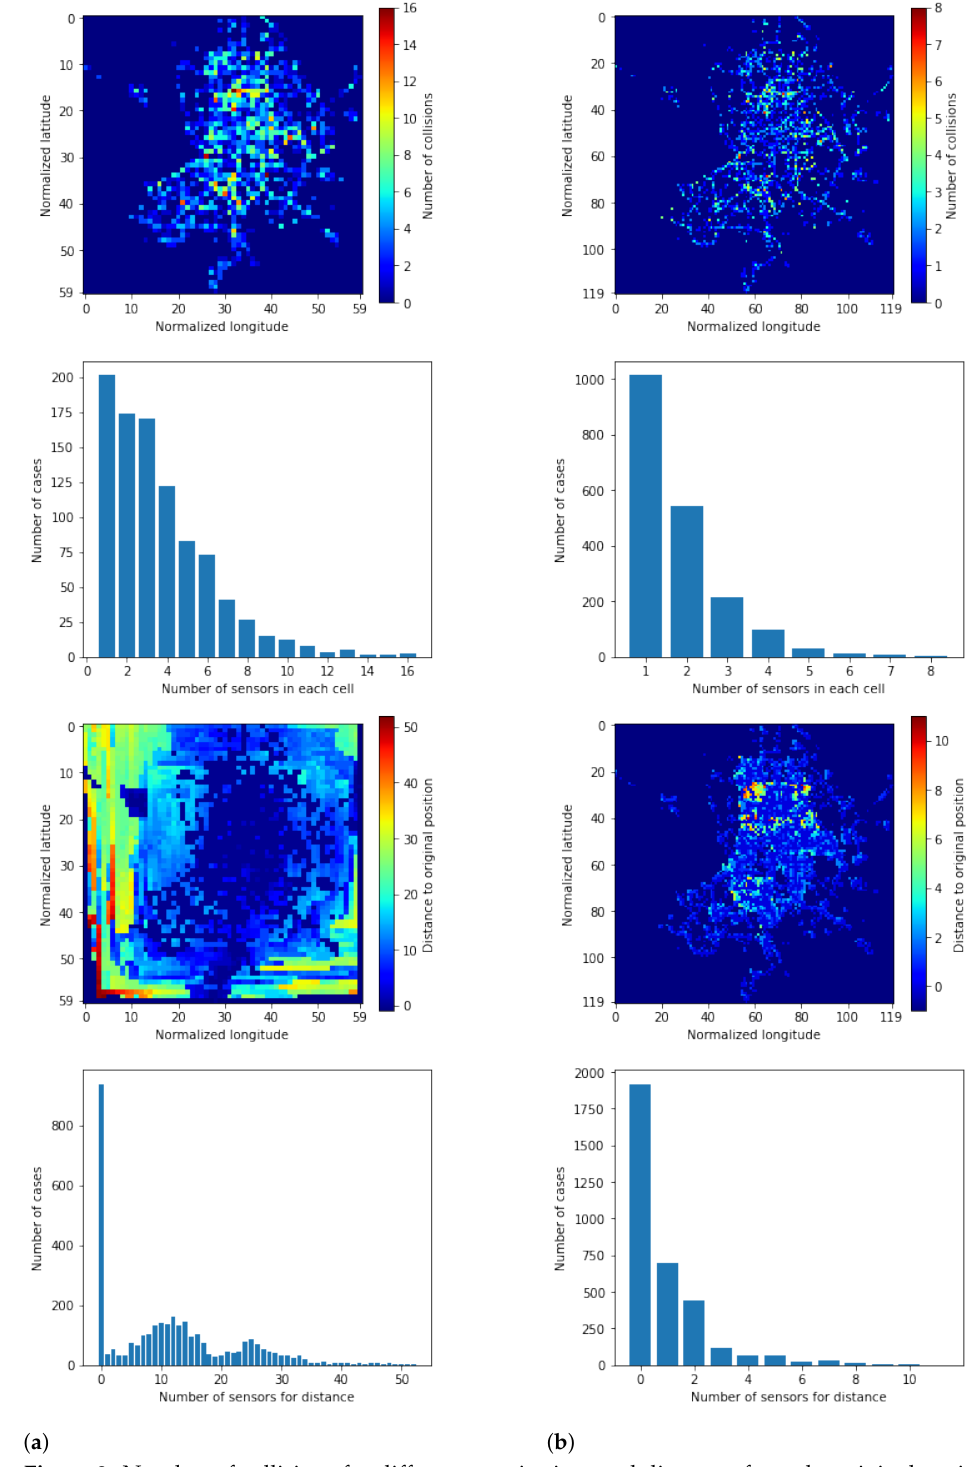
Figure 3. Number of collisions for different matrix sizes and distances from the original position when the station was repositioned. ( a ) Sensors in a 60 × 60 matrix. ( b ) Sensors in a 120 × 120